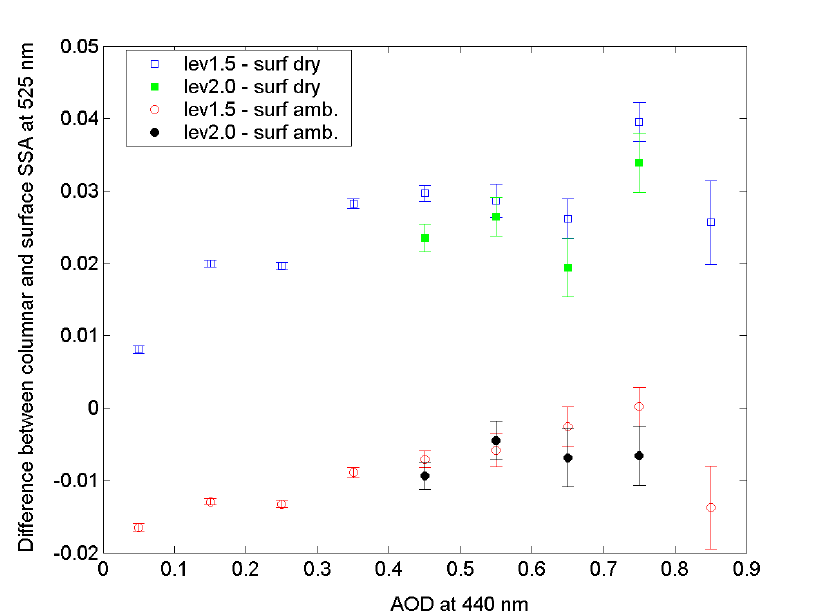
Figure 10. Difference between columnar and surface SSA (aethalometer + nephelometer) at 525 nm as a function of AOD at 440 nm for Level 1.5 AERONET data at dry (blues squares) and ambient conditions (red circles) as well as for Level 2.0 AERONET data and at dry (green solid squares) and ambient conditions (black dotted). The error bars marks the uncertainties related to number of measurements √ N (0.01/